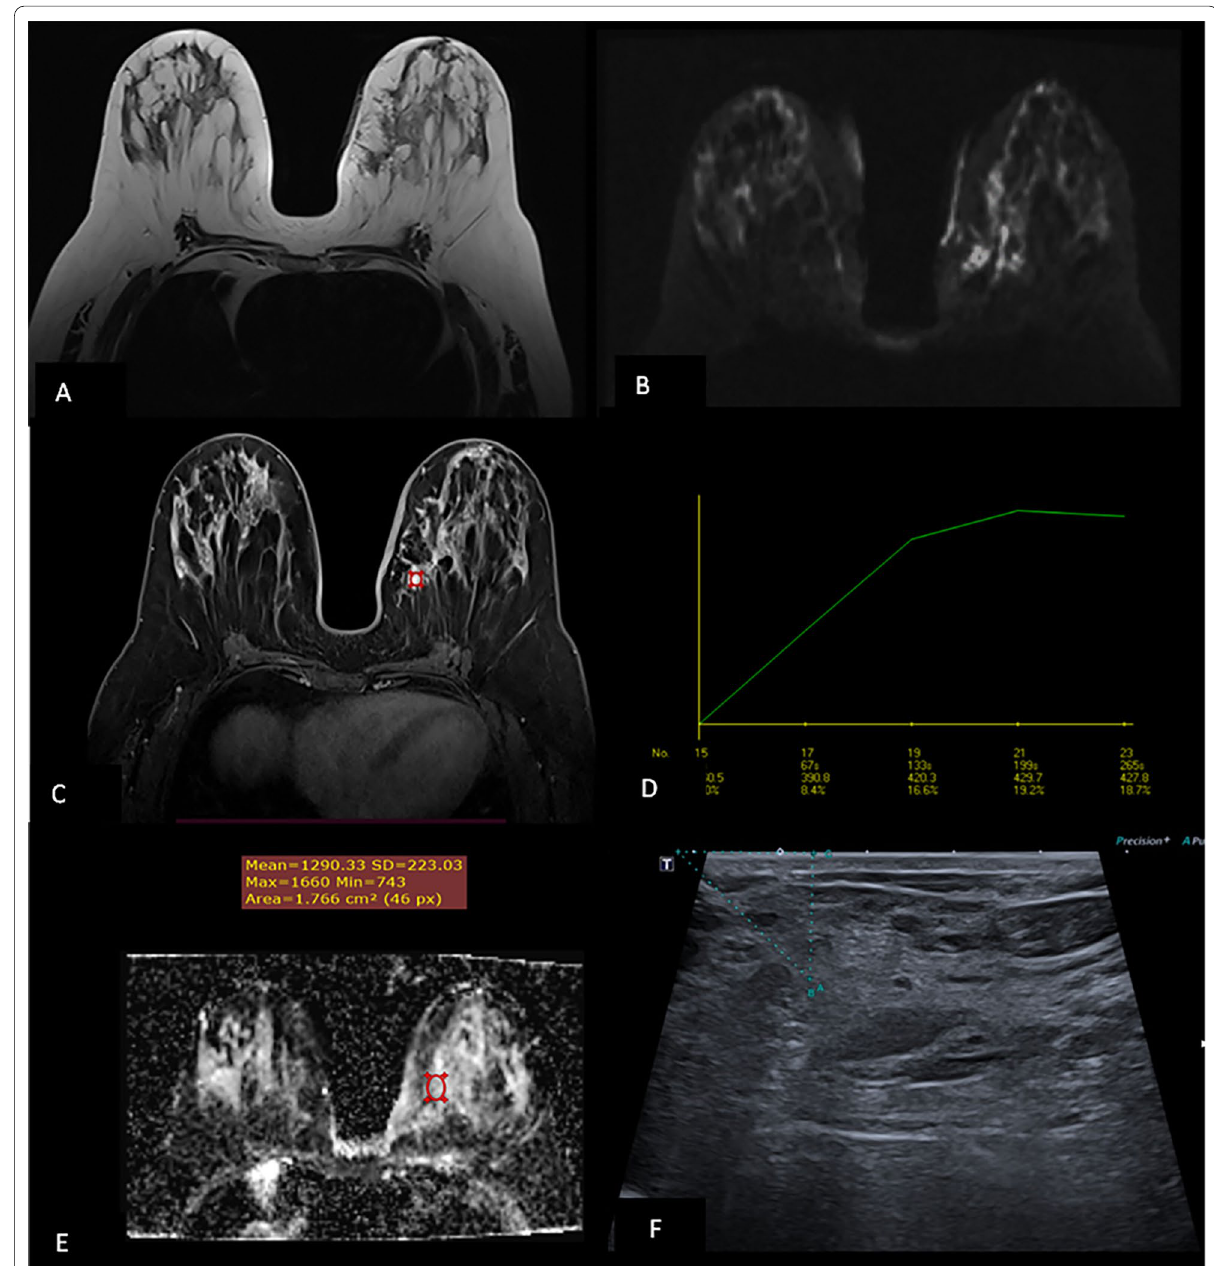
Fig. 5 Case 4: 37 years old presenting with a palpable left breast mass. Sonomammographic assessment revealed focal palpable adenosis (not illustrated in images). DCE‑MRI: T1WI ( A ), STIR ( B ), post‑contrast dynamic sequences ( C ) with Time–intensity curves ( D ), and ADC mapping ( E ) revealed LIQ mass enhancement showing type II plateau curve on plotting time–intensity curve ( D ) and ADC value of 1.29 ( E ). U/S guided trucut histopathology revealed sclerosing adenosis, wire localization ( F ), excision was recommended by MDT, and post‑surgical histopathology revealed no malignant